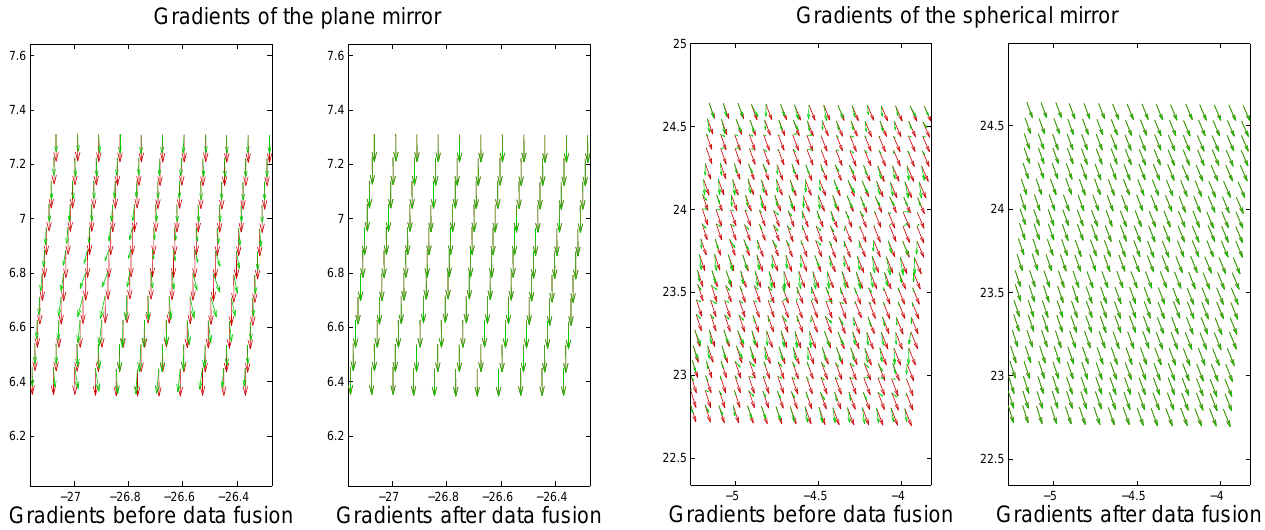
Figure 7. Clipped area of plane and spherical mirror gradients before and after the data-fusion process with 1000 iterations. Measured gradients in red, calculated gradients from the point coordinates in green.